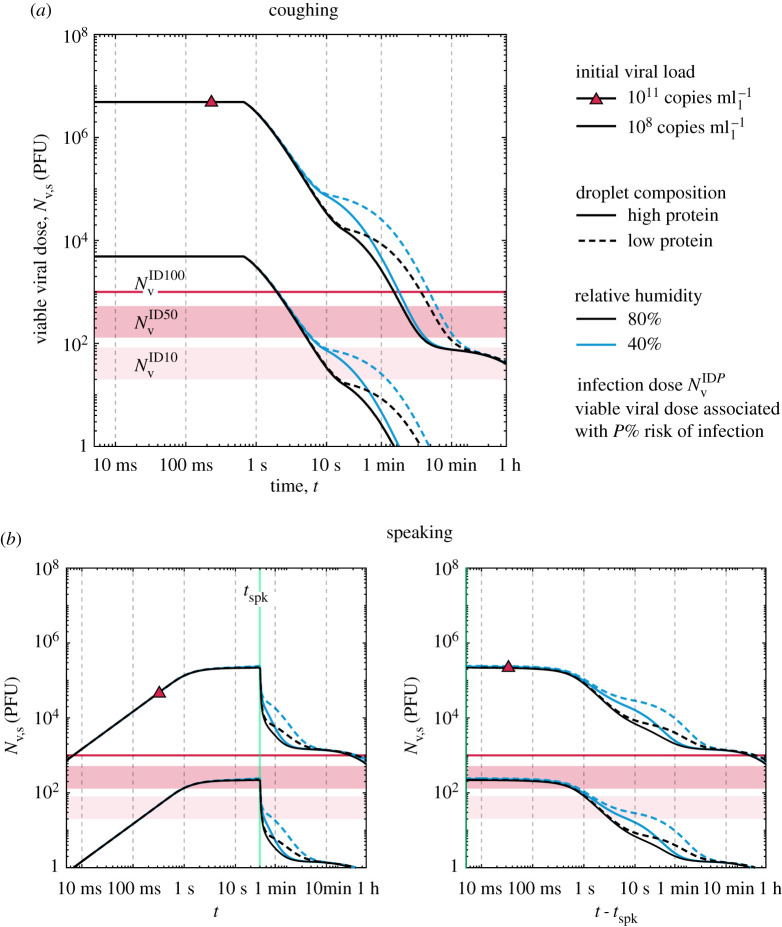
Evolution of the suspended viable viral dose following (a) a short cough and (b) 30 s speech in terms of two droplet compositions (low- and high-protein sputum), RH = 40 and 80%, and low (108 copies mll−l) and high (1011 copies mll−l) initial viral load nv,0. (Online version in colour.)